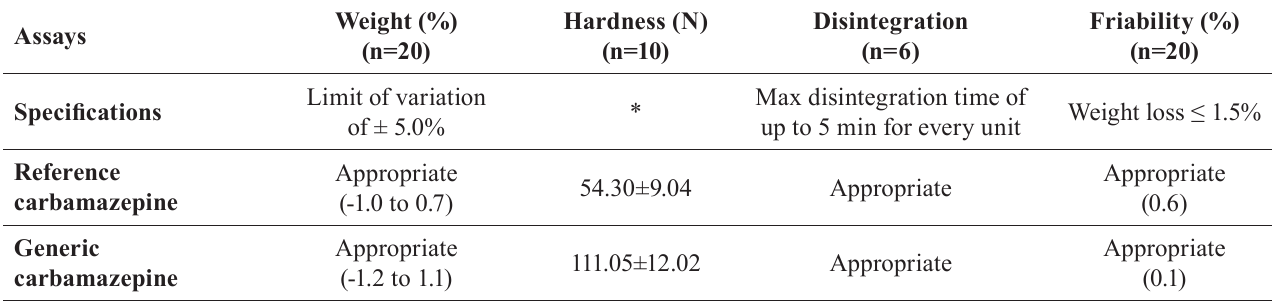
TABLE IV - Weight, hardness, disintegration and friability for carbamazepine reference and generic tablets